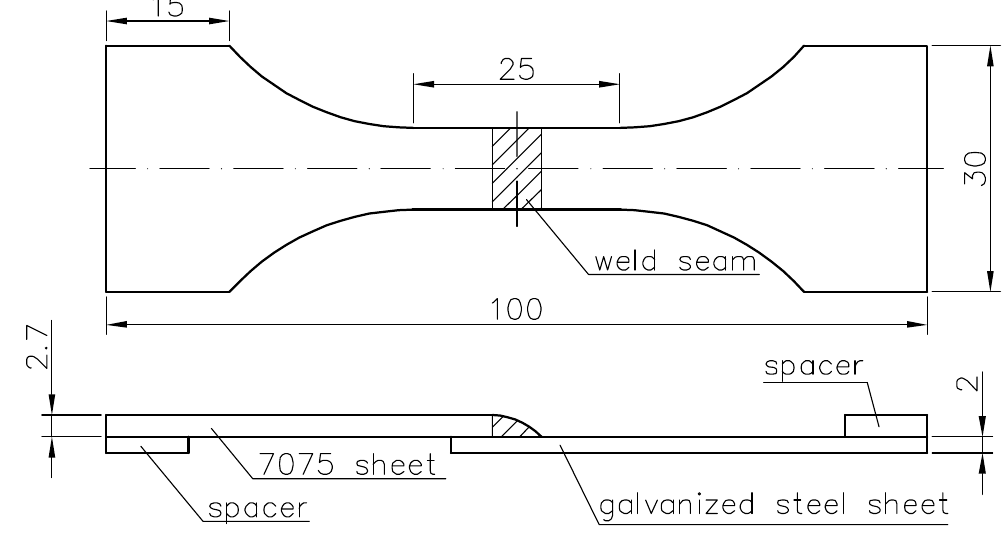
Figure 3. Geometry of the specimen for tensile test.